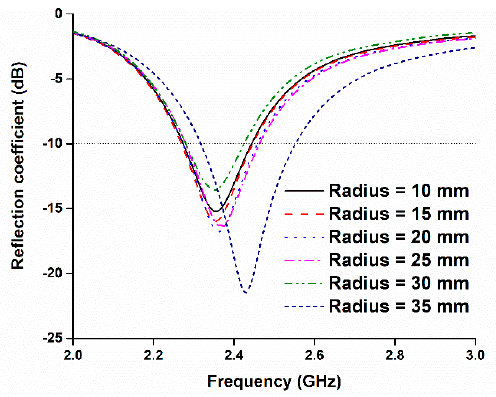
Figure 11. Reflection coefficients of the proposed antenna for different bending (side-by-side) radii.